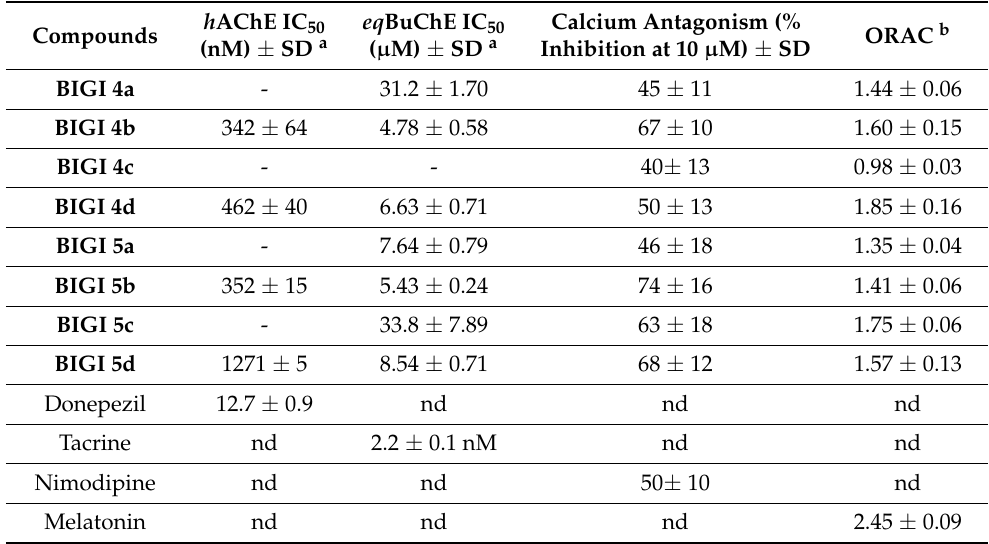
Table 1. Cholinesterases inhibition, calcium blockade percentages, and ORAC (TE) values for compounds BIGI 4a-d and BIGI 5a-d compared with reference compounds.